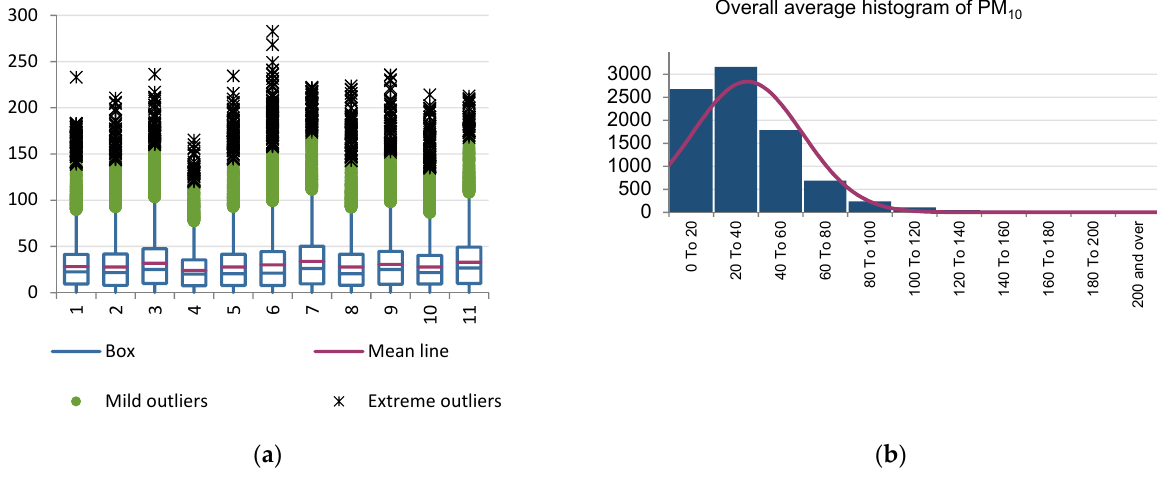
Figure 3. Distribution of PM 10 values recorded throughout the year-long measurements: ( a ) box plot for individual sensors in the cluster and ( b ) histogram of hourly averages (overall averaged values of all